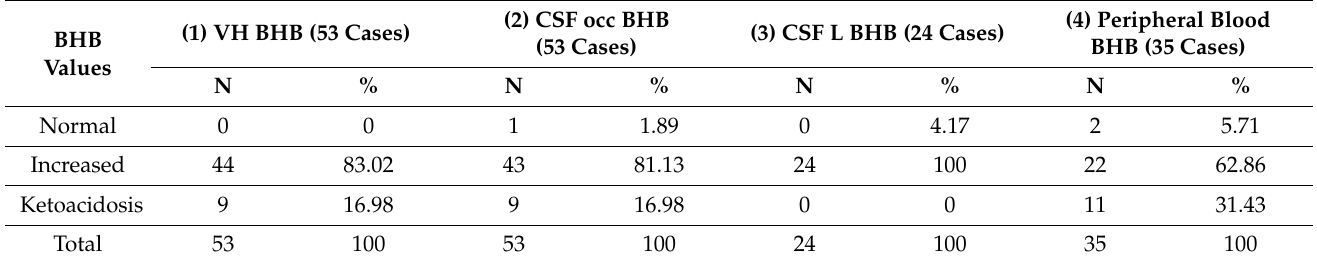
Table 3. Frequency of BHB values according to threshold